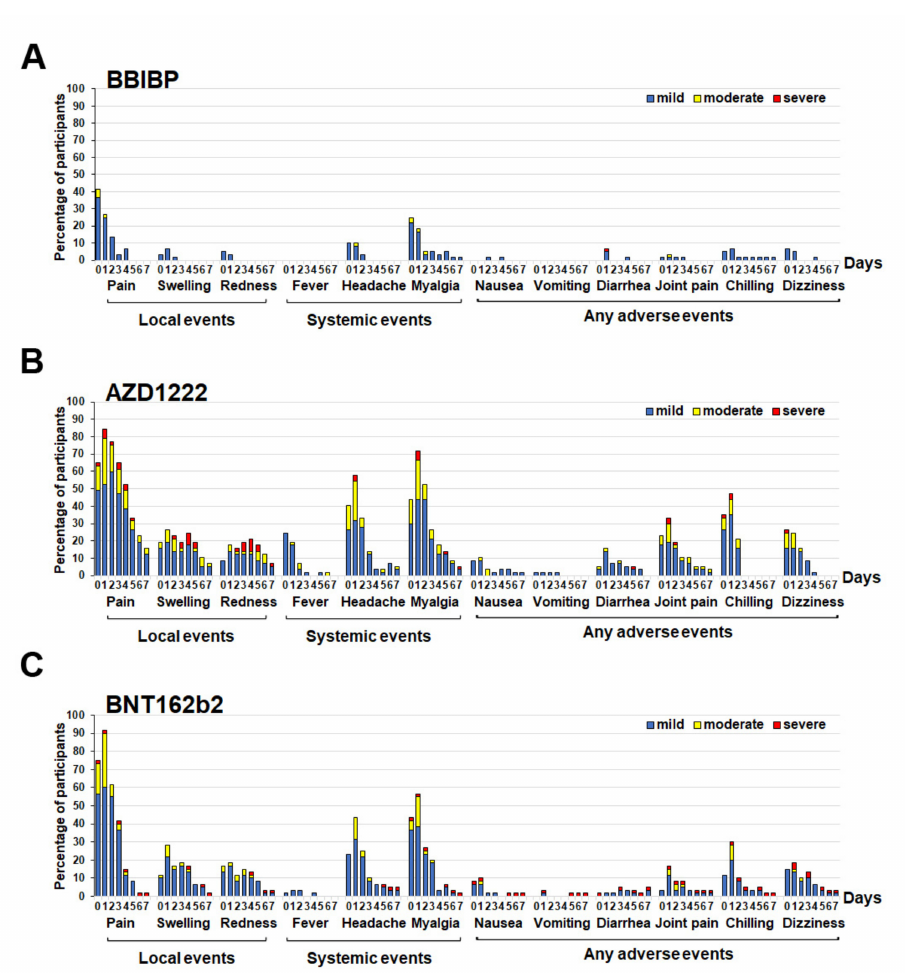
Figure 1. Reactogenicity of a booster dose of SARS-CoV-2 vaccines within 7 days of vaccination. A booster dose of the inactivated vaccine BBIBP ( A ), viral vector vaccine AZD1222 ( B ), and mRNA vaccine BNT162b2 ( C ). The percentages of participants who recorded local, systemic, and any adverse events are shown on the Y-axis. Fever was defined as mild: 38.0 ◦ C to <38.5 ◦ C; moderate: 38.5 ◦ C to <39.0 ◦ C; severe: ≥ 39.0 ◦ C. For local and systemic symptoms, grading was classified as mild— easily tolerated with no limitation on regular activity; moderate—some limitation of daily activity; severe—unable to perform regular daily activity